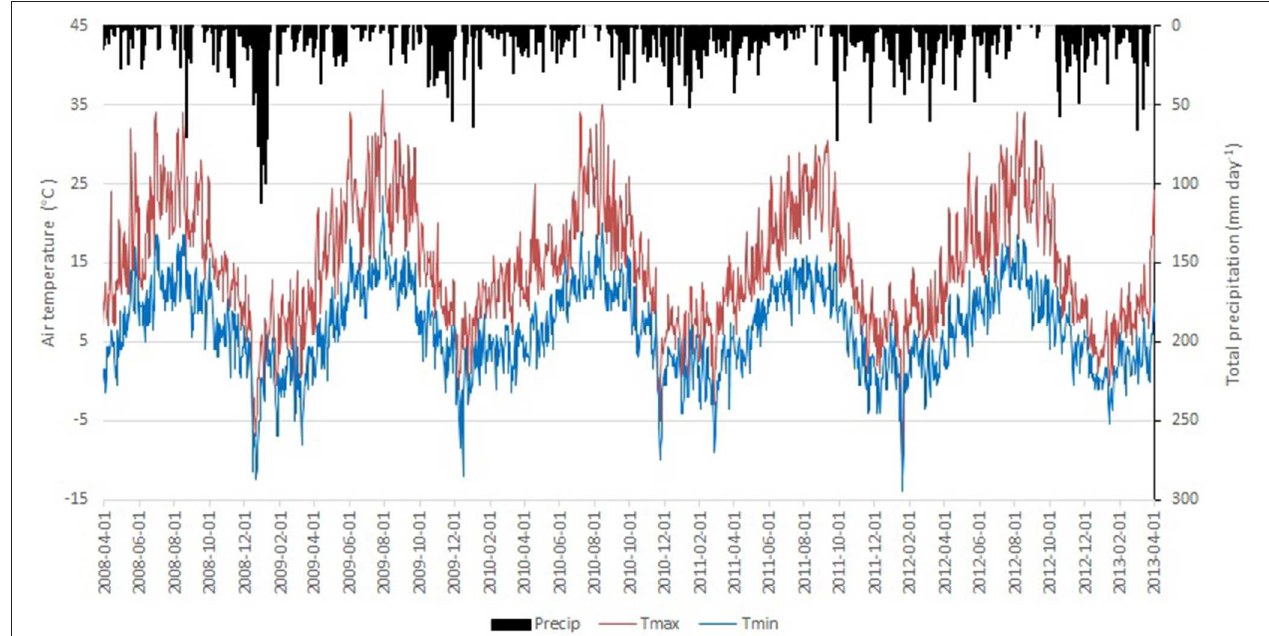
FIGURE 1 | Daily minimum and maximum temperature ( ◦ C) and precipitation between April 2008 and March 2013.